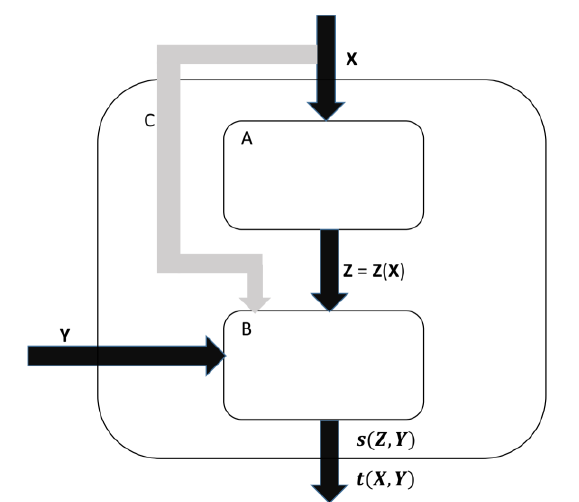
Fig. 1. Layout of generalized problems of digital circuit design (If the sneaky (dotted) path is needed, the function 𝒔(𝒁. 𝒀) is replaced by 𝒔(𝑿, 𝒁, 𝒀)